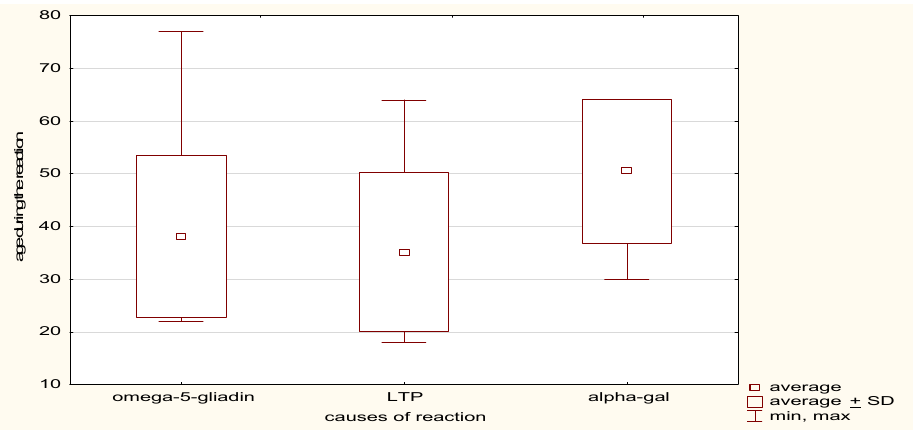
Figure 2. The age in analysed group—average, SD, minimum, and maximum, with division into individual causes.